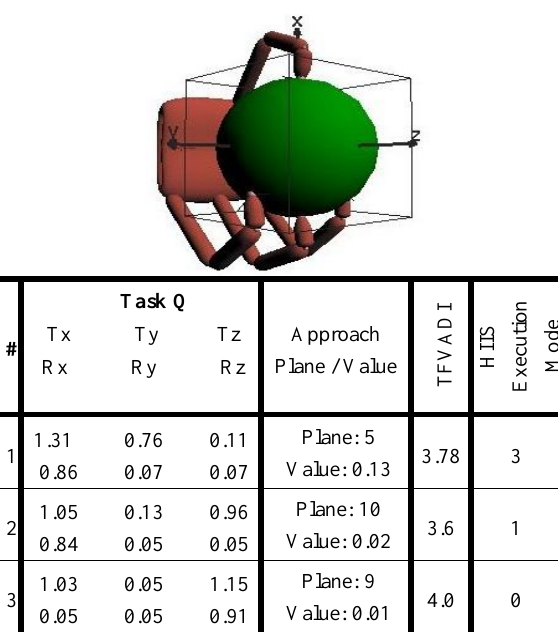
Figure 12 Testing HIIS learning with a simple object